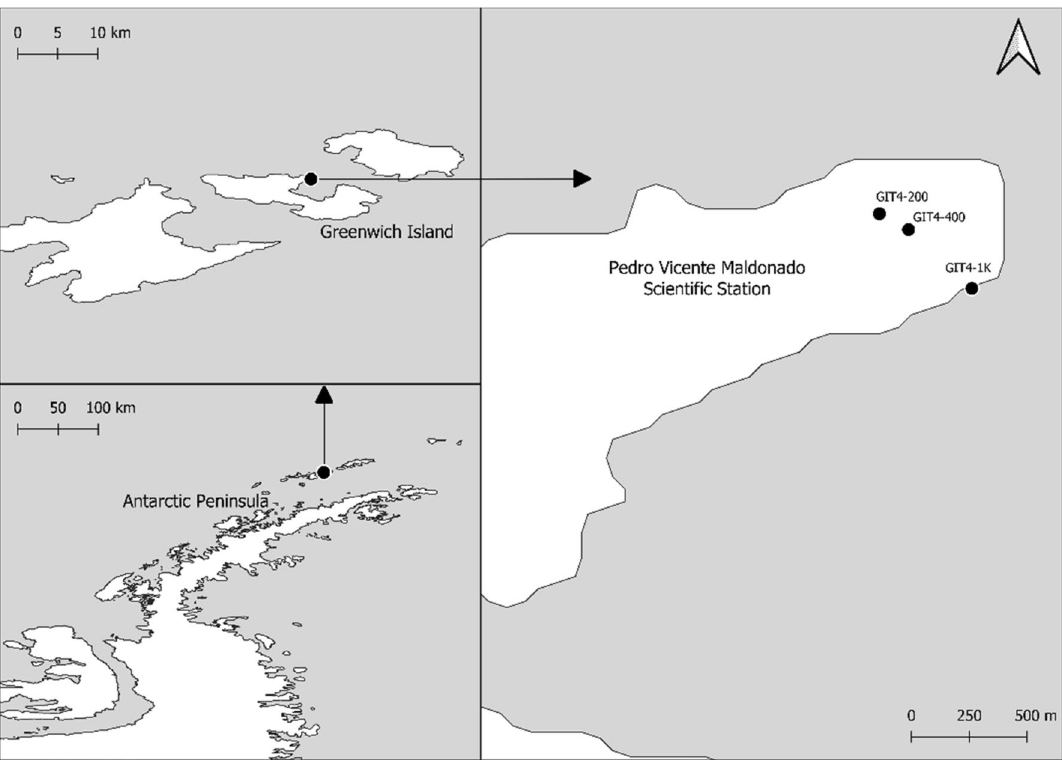
Figure 5. Location of Pedro Vicente Maldonado Scientific Station in Greenwich Island, Antarctica. The geographic location of the three land stations sampled are: GIT4-200 (62°26 ′ 53.9 ″ S 59°44 ′ 07.7 ″ W), GIT4-400 (62°26 ′ 58.7 ″ S 59°43 ′ 58.9 ″ W), and GIT4-1 K (62°27 ′ 16.4 ″ S 59°43 ′ 39.8 ″ W). The map was generated in